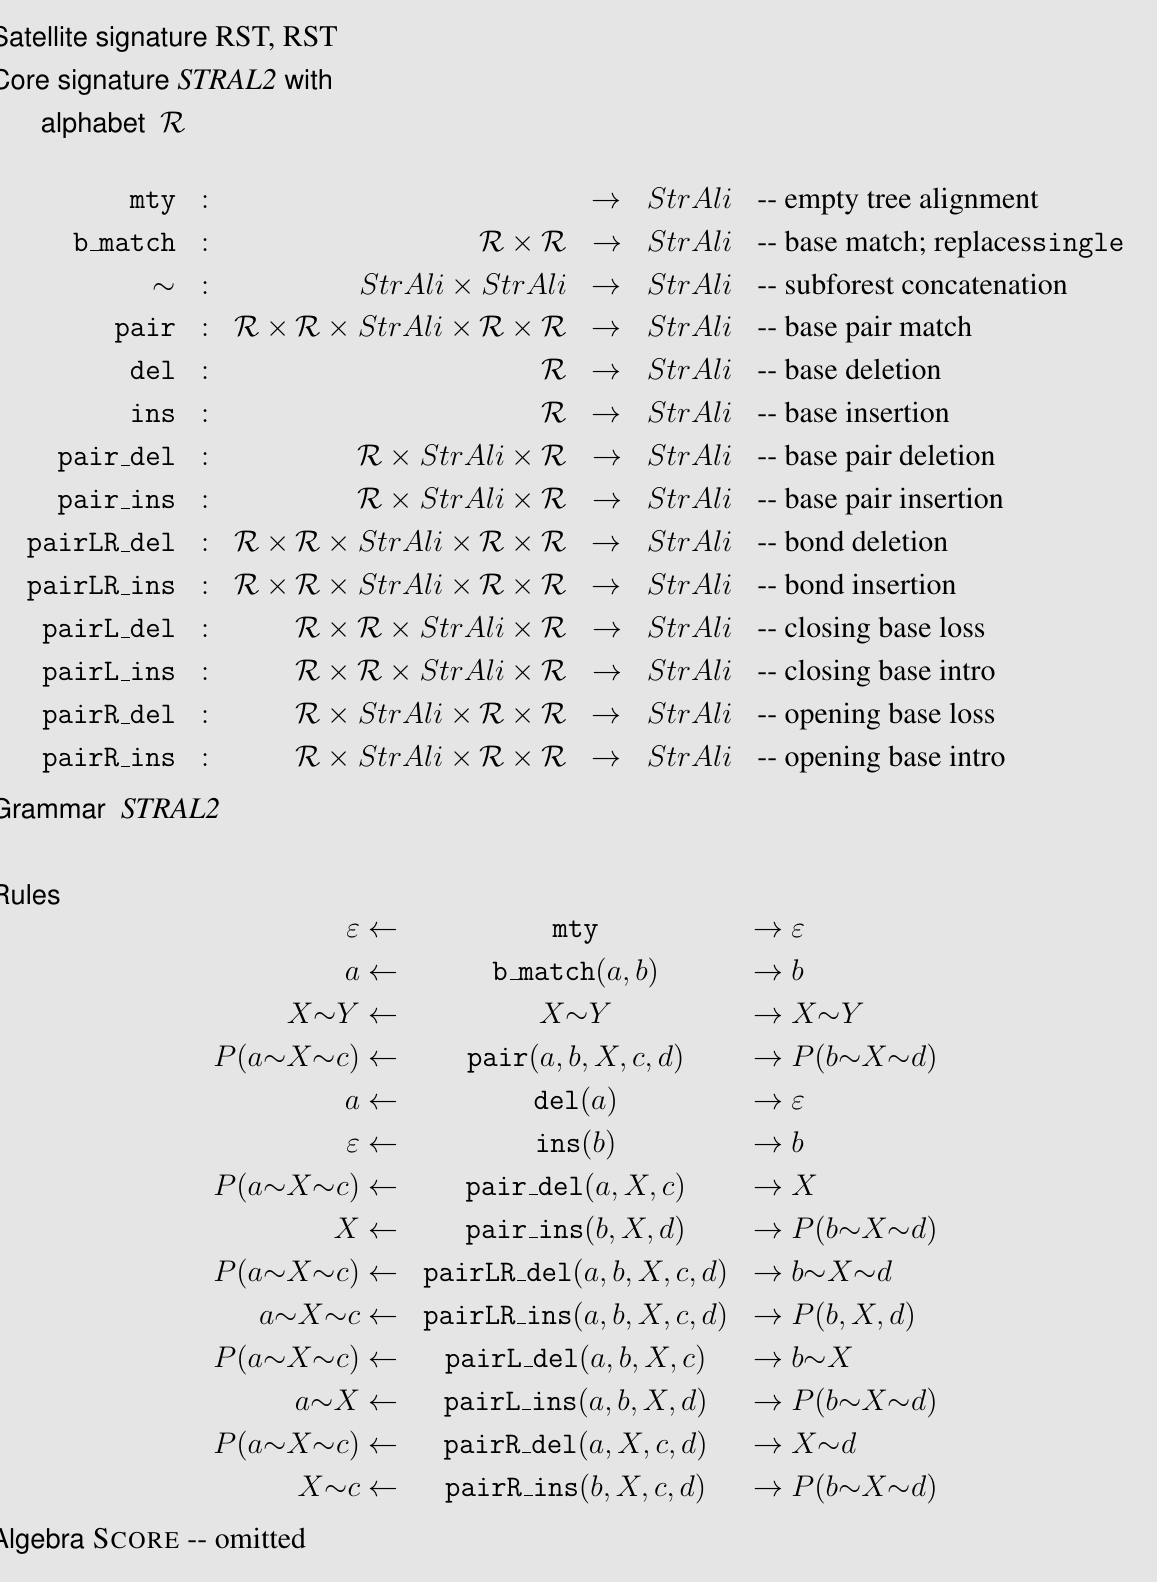
ICORE RNAT REE A LI : dimension 2 Satellite signature RST,